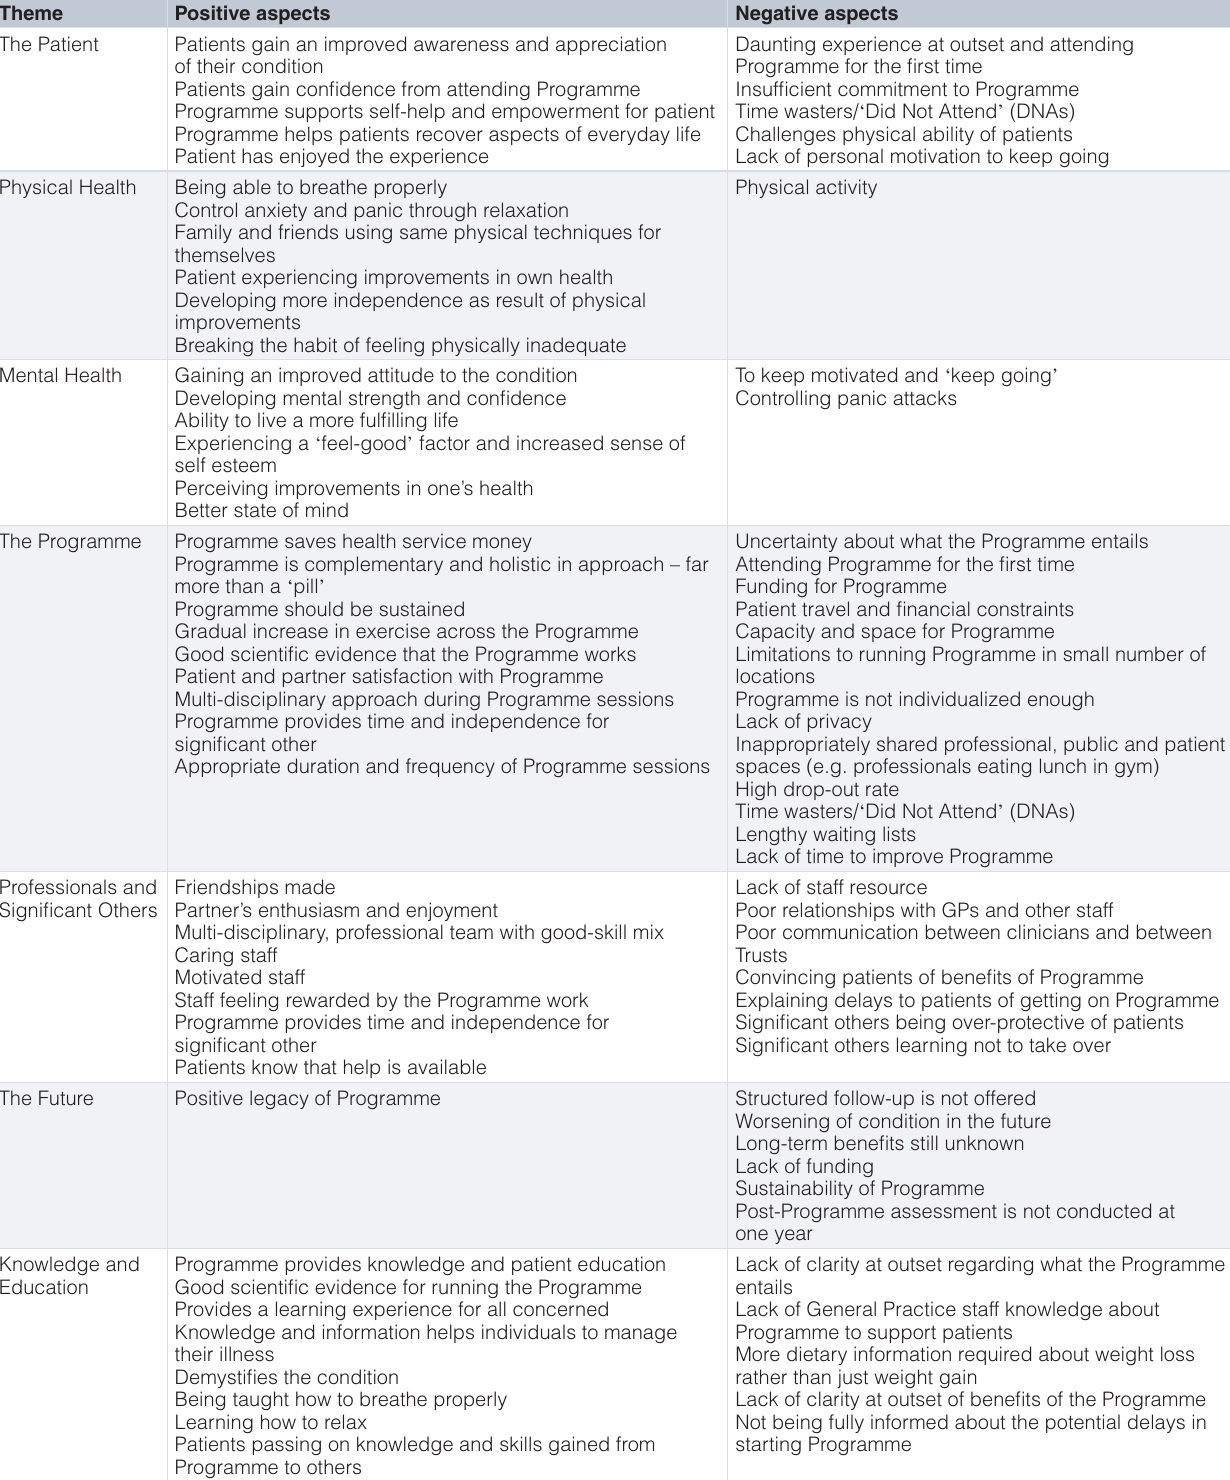
Table 3. Final themes encompassing positive and challenging aspects of Pulmonary Rehabilitation